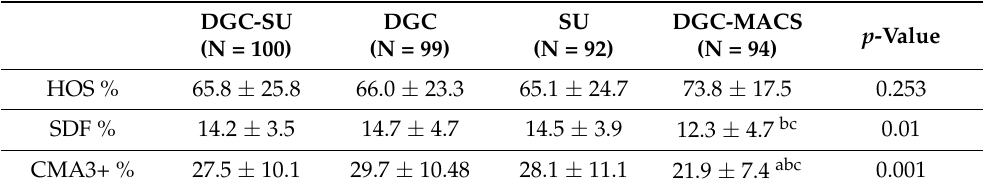
Table 3. TNMS (total normal motile sperms), HOS % (hypo-osmotic swelling), SDF% (sperm DNA fragmentation) and CMA3+% levels in the whole studied population after preparation of patients with TZs.